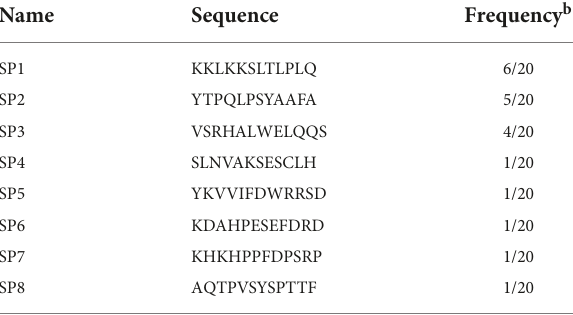
TABLE 4 The sequence of epitope peptide candidates a .